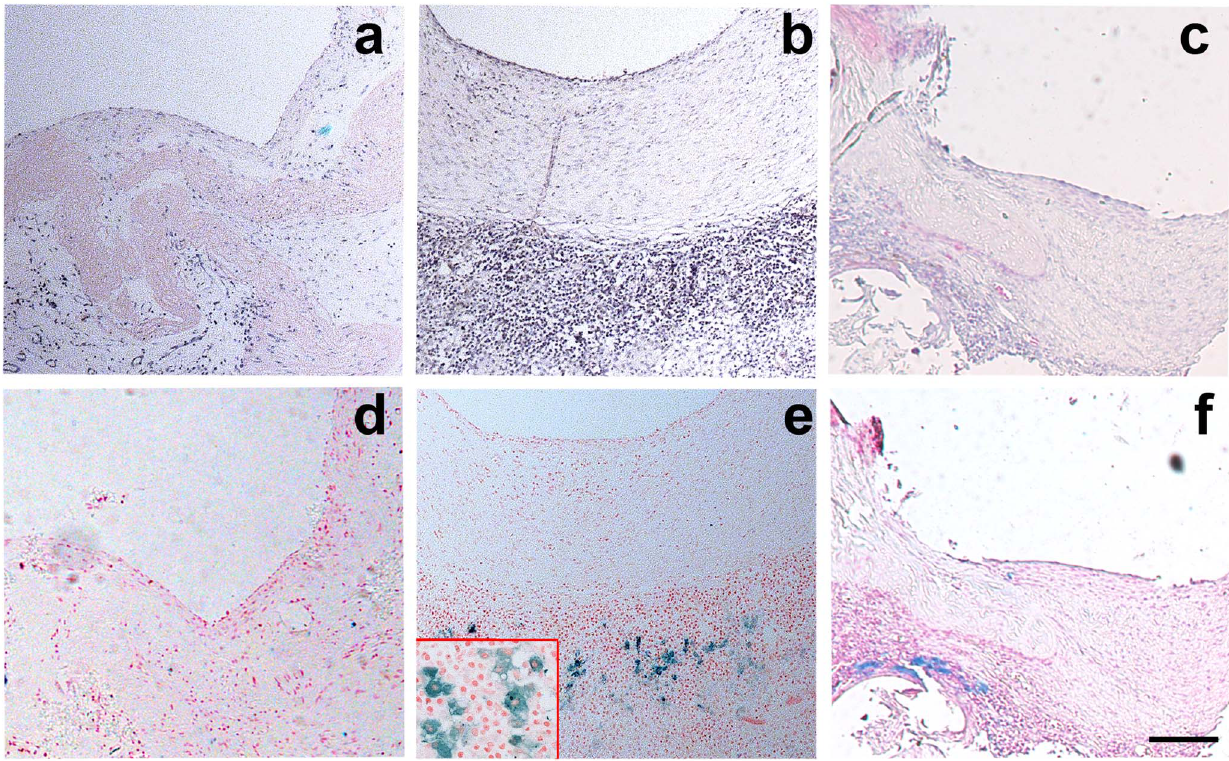
Figure 5. BM-EPCs involved in aneuryam repairing. HE staining showing that the tissue repairation of aneurysm neck in EPC transplantation group ( b ) is better than in HUVEC transplantation group ( c ) and PBS control group ( a ). Prussian blue staining showing SPIO-labeled cells located in the aneurysm neck of all rats in the EPC transplantation group ( e ), in contrast to the HUVEC transplantation group ( f ) and control group ( d ). Bar=100 m m.